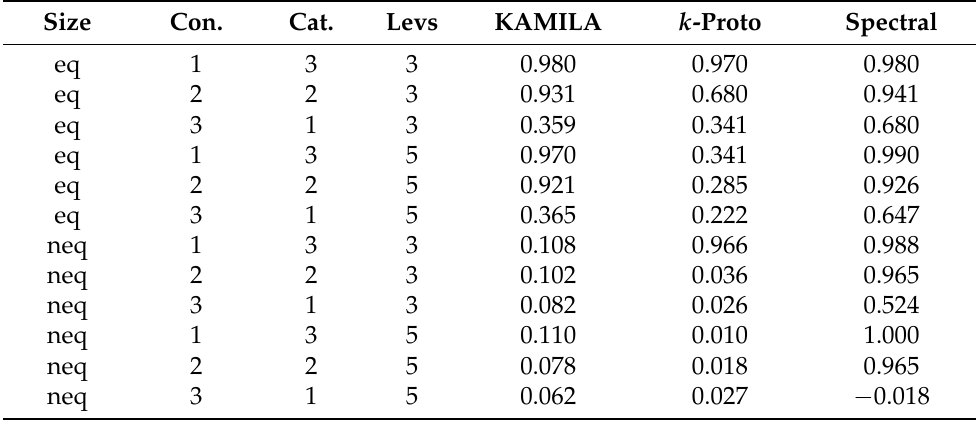
Table 1. Median ARI for low overlap in continuous variables and low overlap in categorical variables, n = 100 two-cluster data